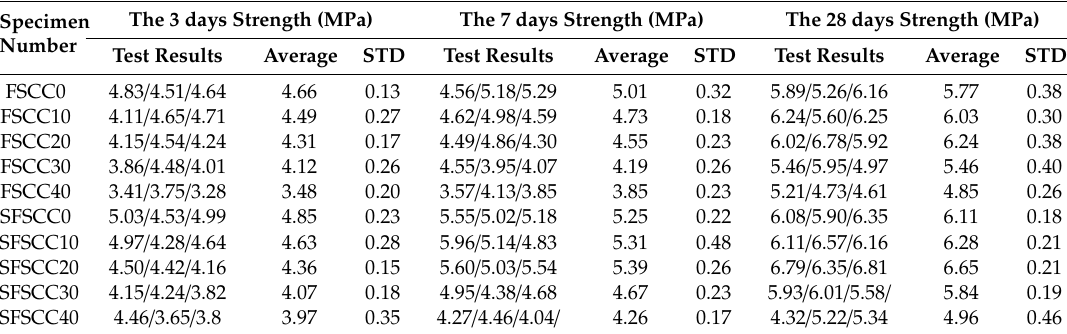
Table 7. Test results of 56 days and 91 days splitting strength of SCC.